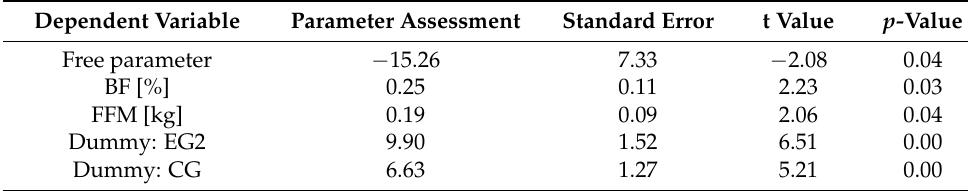
Table 9. Parameters of multiple regression model of the IL-6 dependent variable. Dependent